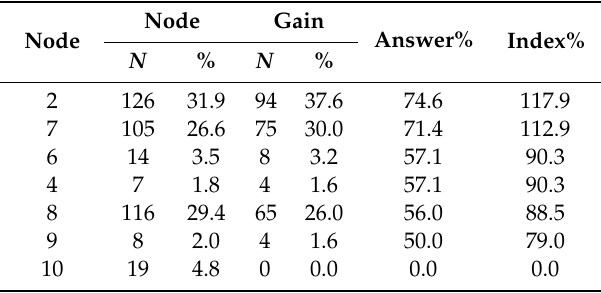
Table 6. Earnings for nodes: target those who do use